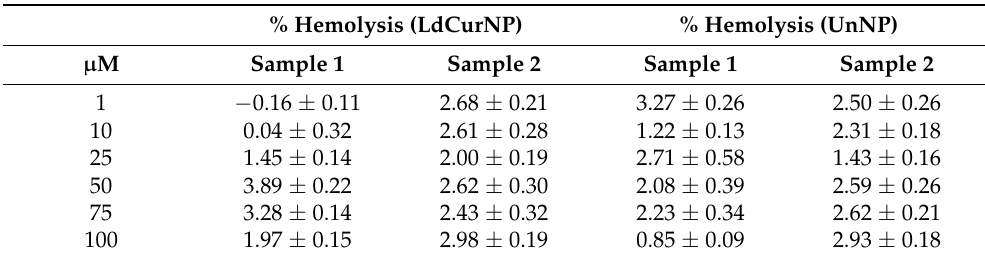
Table 3. Hemolysis assays of the L-DOPA and curcumin-loaded nanoparticles (LdCurNPs) and unloaded nanoparticles (UnNPs) results presented as mean ± standard error. % Hemolysis (LdCurNP) % Hemolysis (UnNP) µ M Sample 1 Sample 2 Sample 1 Sample 2 1 − 0.16 ± 0.11 2.68 ±